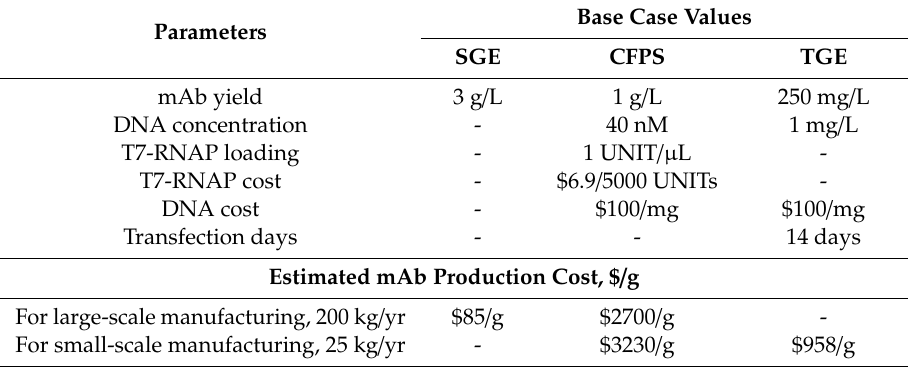
Table 2. The base case values for the process parameters in mAb production via SGE, CFPS, and